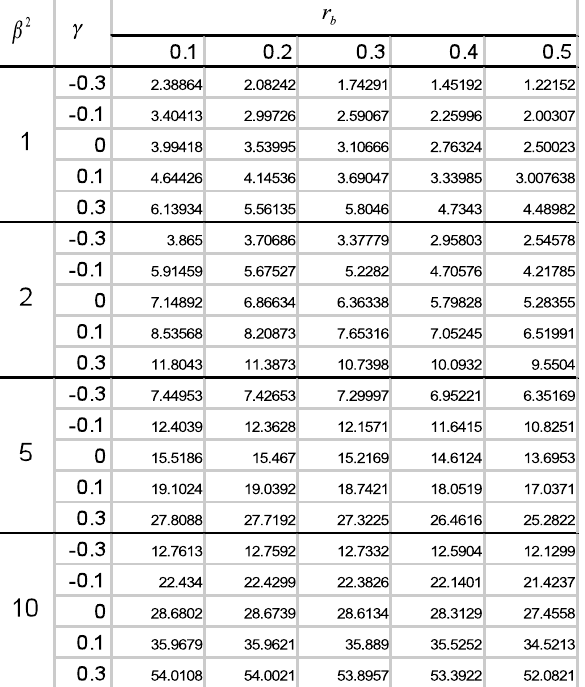
Table 3. Buckling load factor variation with clamped outer edge